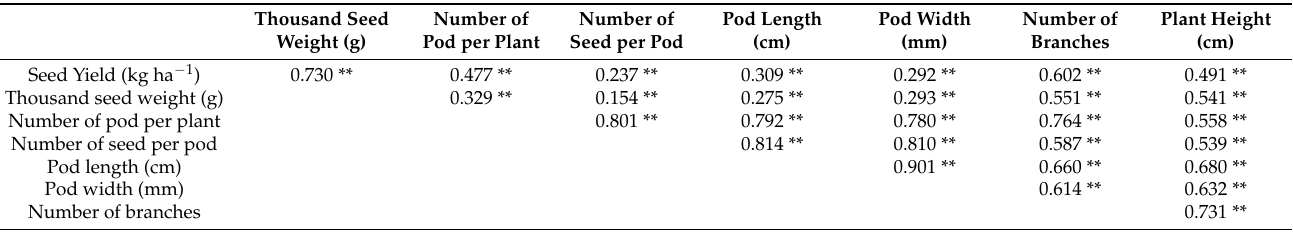
Table 5. Correlations between all traits measured: seed yield (kg ha − 1 ), thousand seed weight (g), number of pod per plant, number of seed per pod, Pod length (cm), pod width (mm), number of branches and plant height (cm). Thousand Seed Number of Number of Pod Length Pod Width Number of Plant Height Weight (g) Pod per Plant Seed per Pod (cm) (mm) Branches (cm) Seed Yield (kg ha − 1 ) 0.730